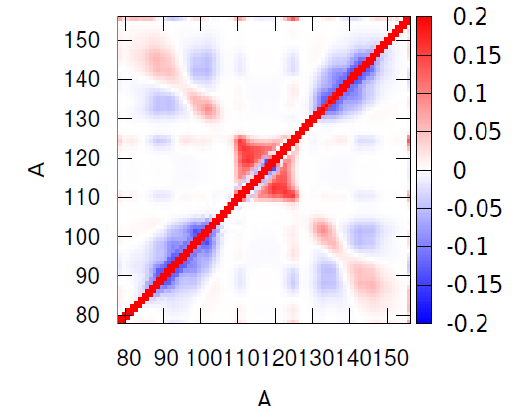
Fig. 2. Mass yield correlation matrix from CEA (2015) [10, 11] considering only the uncertainties of Brosa’s fission mode parameters The LOHENGRIN (ILL) collaboration on fission studies developed an experimental methodology to obtain absolute measurement of mass yields with not model input in this analysis and the correlation matrix come from the competition of the positive component of systematic uncertainties and the negative component due to the self-normalization [13].